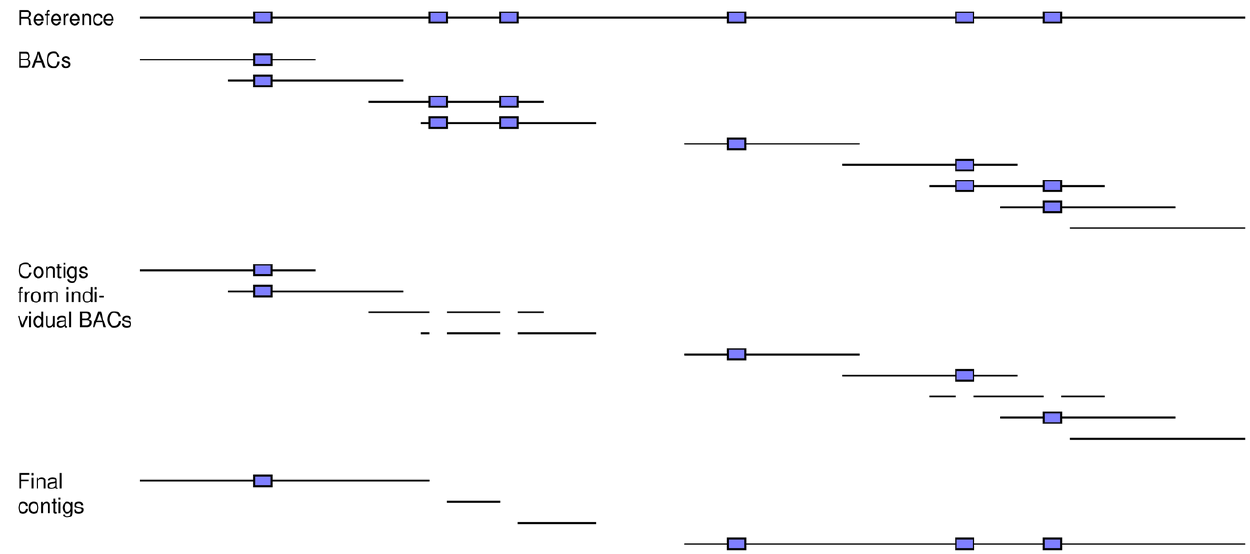
Figure 8. How BAC sequencing can achieve better assemblies and can be modeled by our simulation tools. A number of BAC clones is simulated from the reference, which includes six repeats (blue boxes). A sufficient coverage of reads is generated for each fragment and then assembled into contigs on a clone-by-clone basis. These contigs are next assembled across the clones to generate the final ones for the full set of reads. In this example, clones can carry single copies of the repeats, thereby allowing for unambiguous assembly of their reads into contigs. This divide-and-conquer approach results in greater resolution for the final across-clone assembly of these